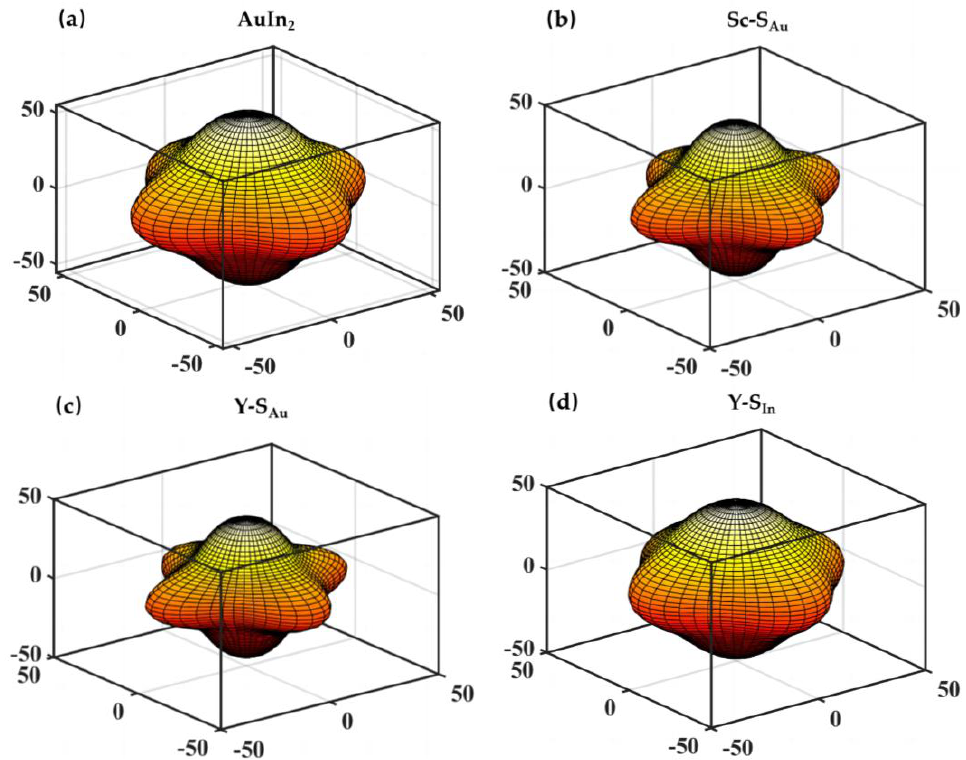
Figure 5. Three − dimensional surface structures of shear modulus of AuIn 2 and RE doping systems; the units are GPa. ( a ) AuIn2 ( b ) Sc-SAu ( c ) Y-SAu ( d )